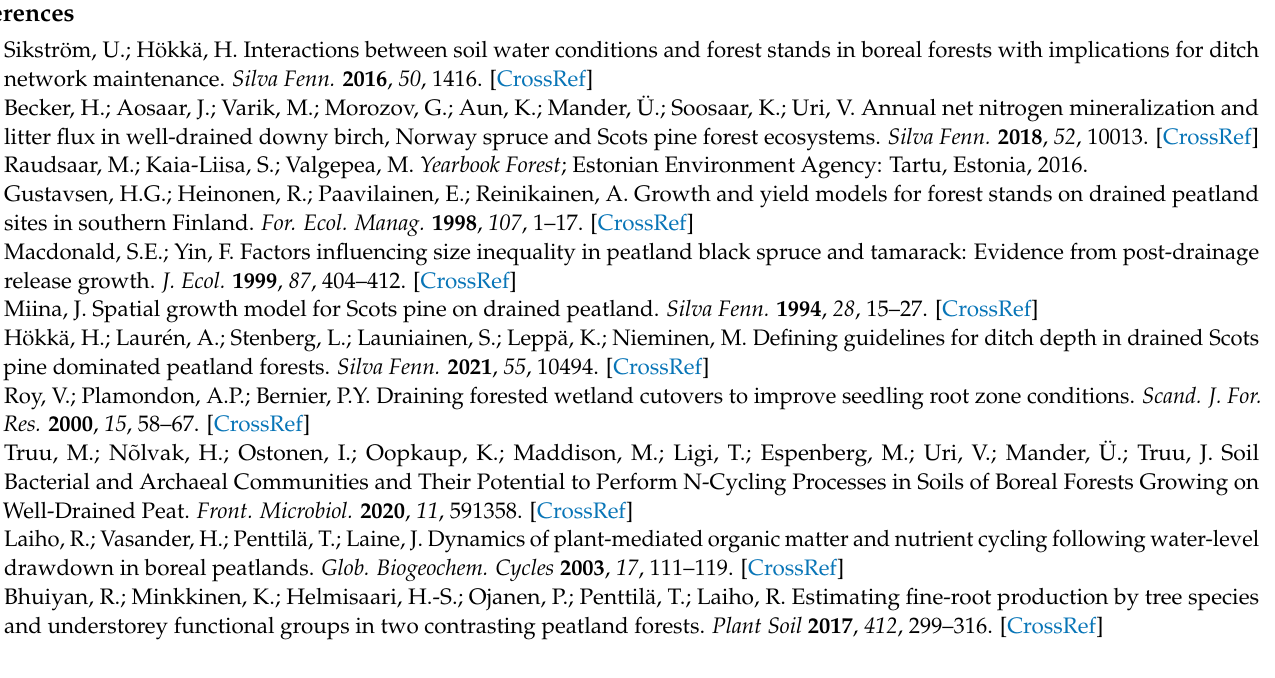
Table S1: The means ± standard errors of absorptive root morphological traits of sampling plots (5, 15, 40, and 80) in replicate stands for birch (B1–B3) and spruce (S1–S3), and of all sampling plots per birch and spruce replicate stand studied in 2018, Table S2: Pearson’s correlation analyses between soil parameters of the forest stands for birch and spruce, Table S3: The effects of forest stands and distance from the ditch (m) on absorptive root morphological traits in birch and spruce perfomed by general linear model